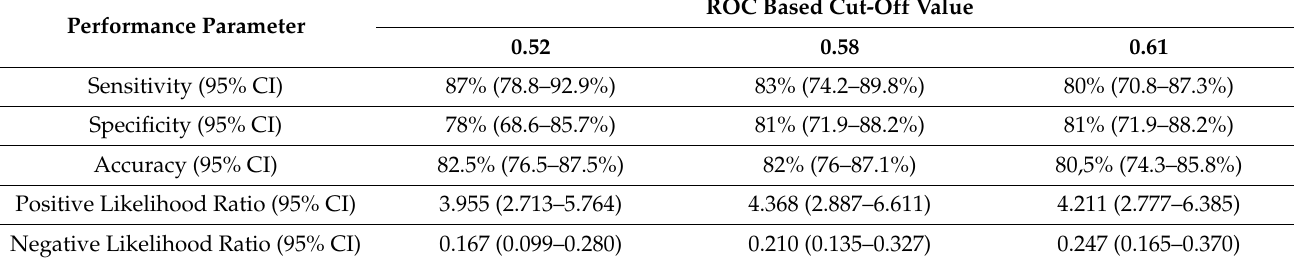
Table 3. Clinical performance of the Bio-Rad Platelia sandwich ELISA when testing serum samples from non-neutropenic patients with pulmonary infections and control healthy individuals using ROC based cut-off